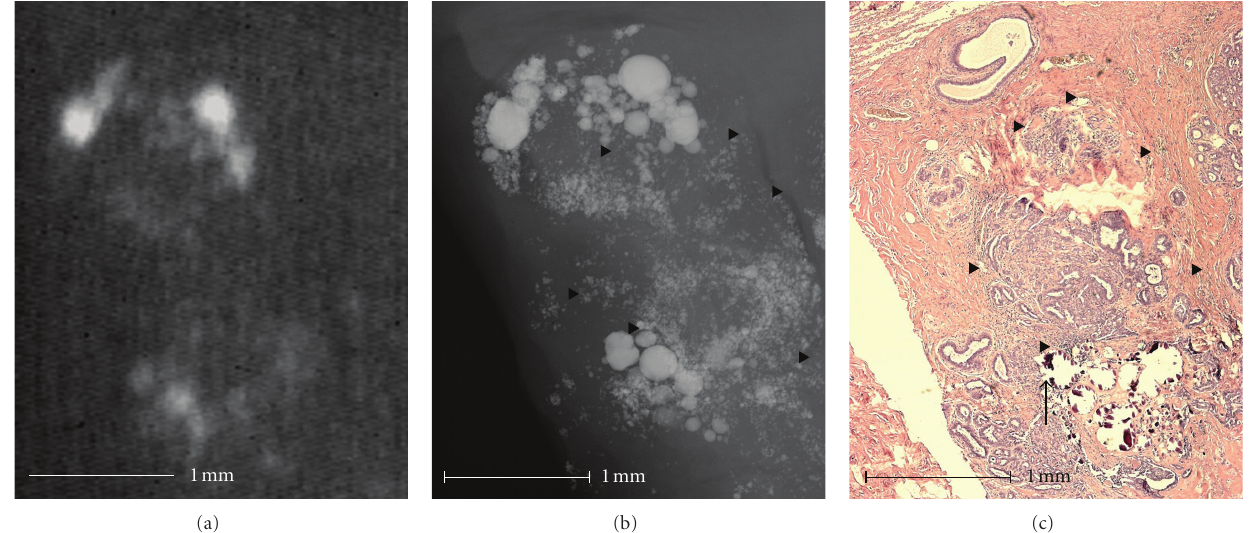
Figure 4: Fibrocystic mastopathy with sclerosing adenosis. Conventional specimen radiography show some amorphous and indistinct calcifications (a). The amorphous calcifications are microradiographically displayed as a summation e ff ect of round and smooth calcifications of varying sizes. Di ff use amorphous microcalcifications are also visible (triangles in (b)) and result in the spotted shadowing in conventional specimen radiography. Fibrocystic mastopathy with sclerosing adenosis is demonstrated histologically (c). Only a few fragments of the large round calcifications in the cysts are histologically visible (arrow in (c)). The amorphous calcifications are almost completely lost during histological preparation. As a result of the shape of the calcification area and the specimen, the amorphous calcifications can be clearly correlated to a histological area of sclerosing adenosis (triangles in (b) and (c)). The calcifications are intraluminal calcifications in sclerosing adenosis.